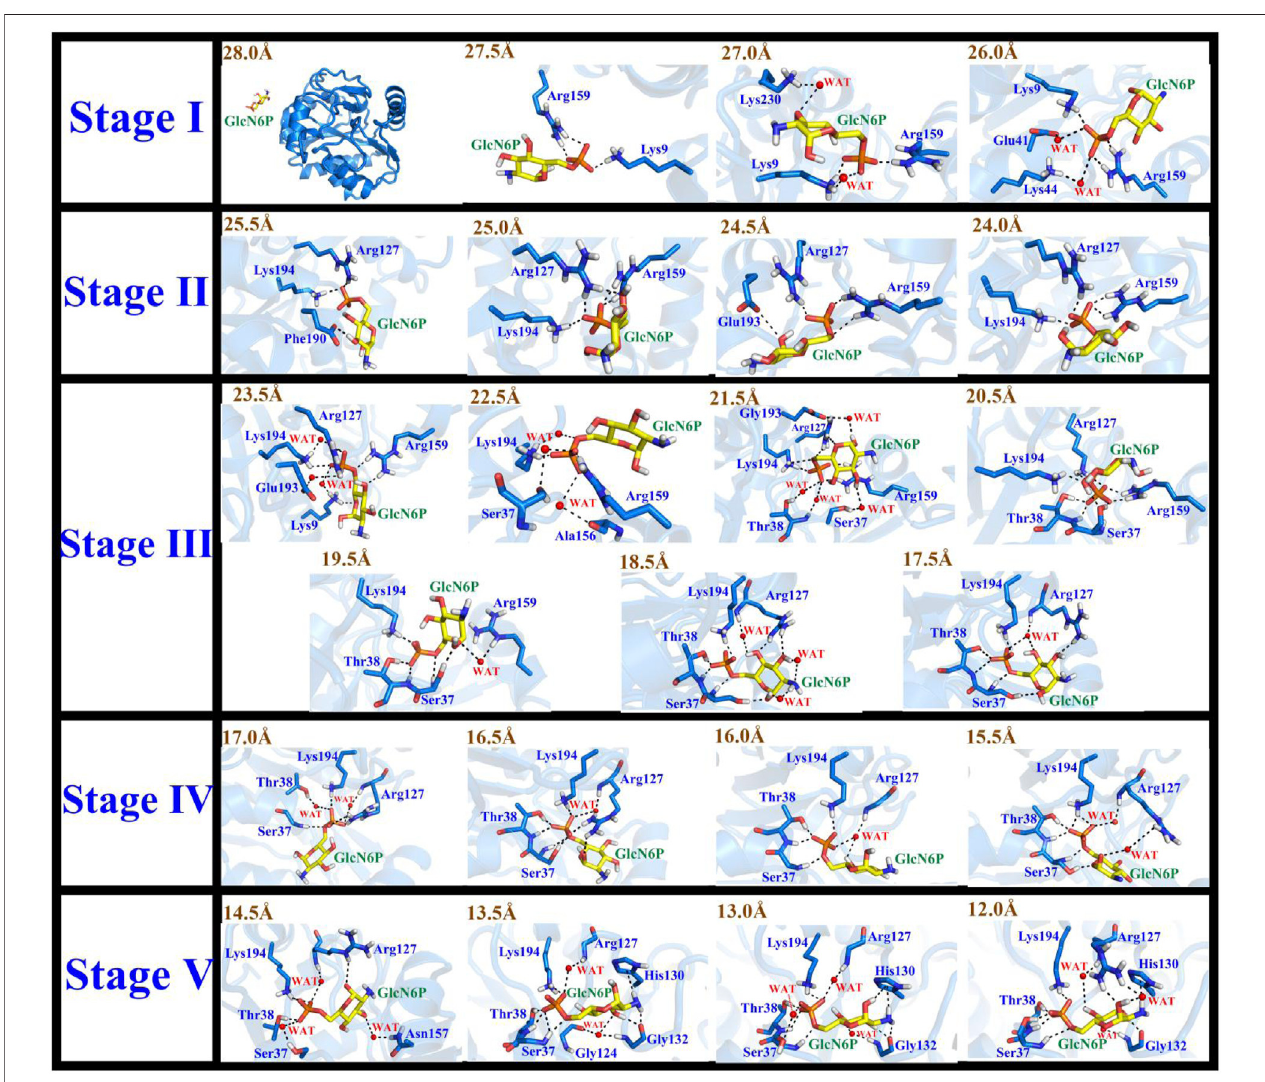
FIGURE 7 | Conformational changes of the substrate and key residues for substrate release along P1 during stages I – V.